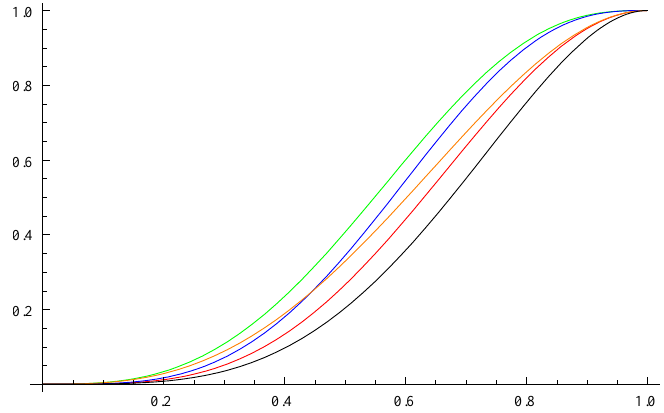
Figure 7. The reliability polynomial of several consecutive-type systems of order n =